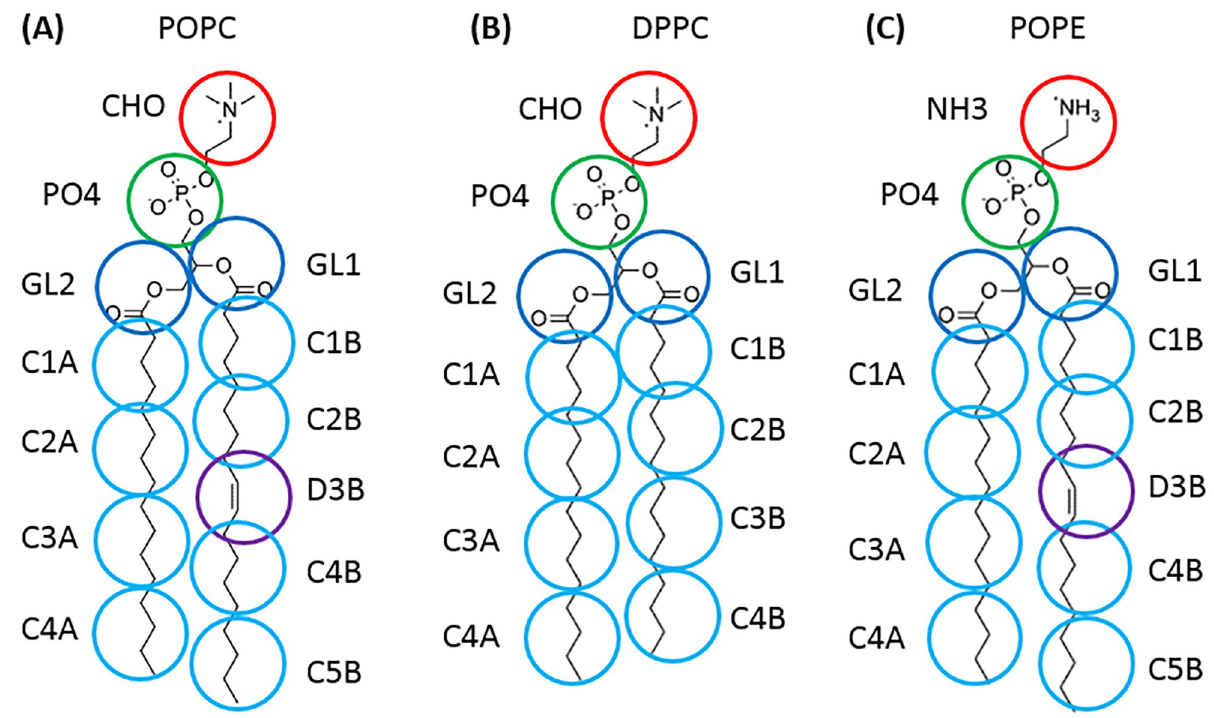
Fig 2. Superimposition of the heavy atoms and MARTINI beads of lipid. (A) POPC, (B) DPPC, and (C) POPE.